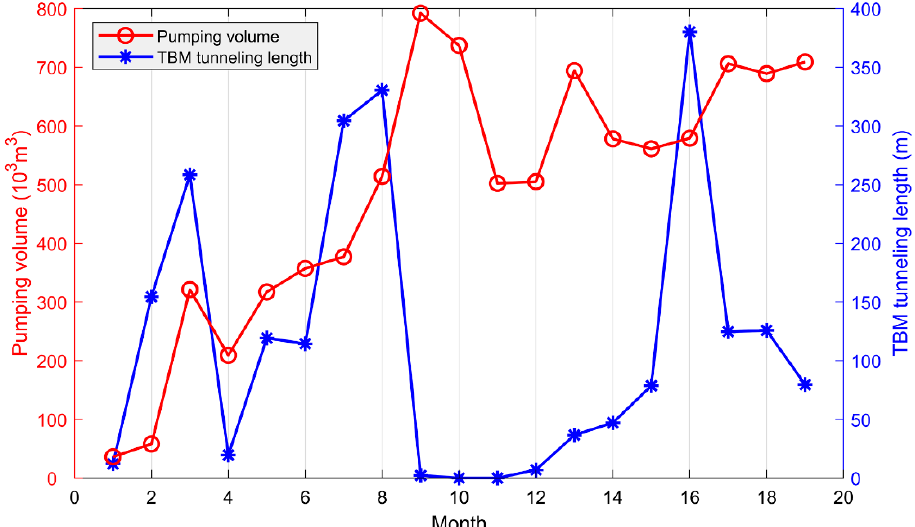
Figure 3. The measured data of the TBM monthly tunneling length and monthly pumping volume of the SS (Shuang-san) tunnel during the 19 months from August 2017 to February 2019.